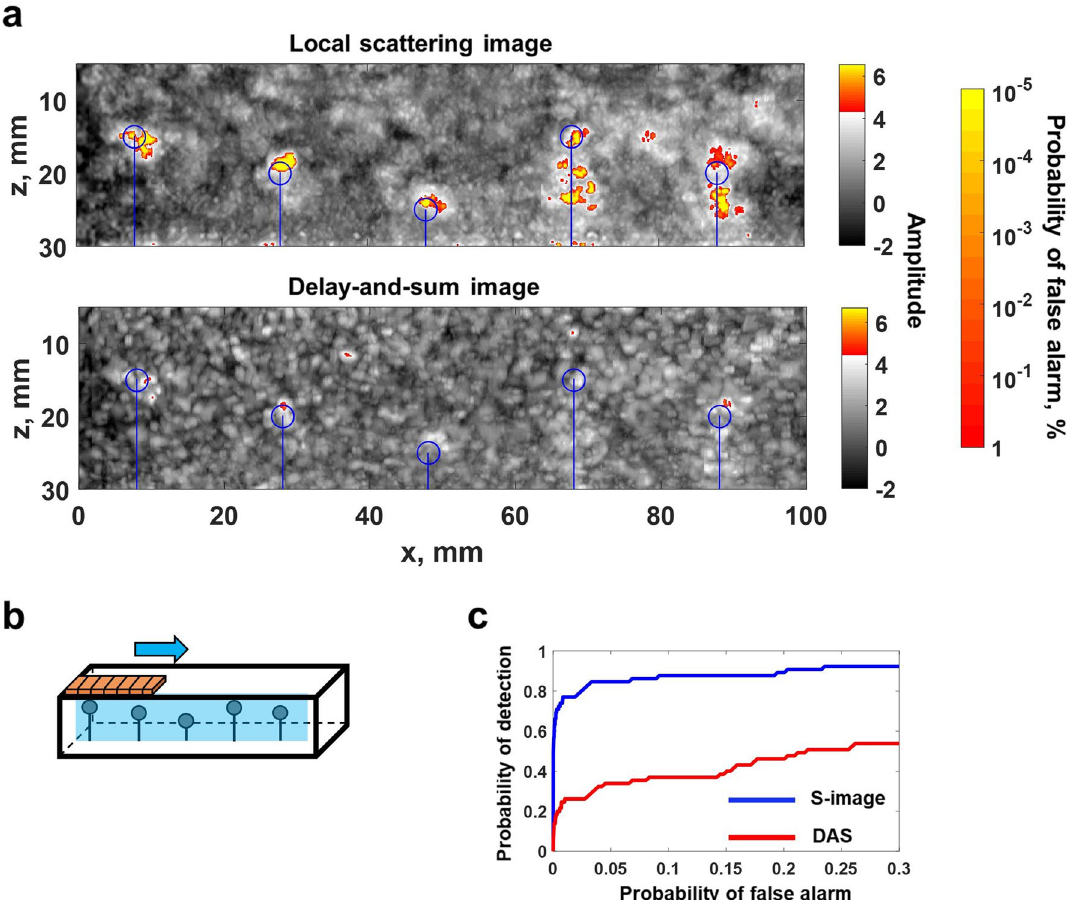
Figure 6. Experimental example of local scattering imaging: scanning along the urethane-rubber sample. ( a ) Local scattering and delay-and-sum images, the value of each pixel equals to the maximum over all scanning array positions. Blue circles indicate the nominal position of inclusions. The global false alarm rate is shown as the second colorbar. ( b ) Diagram illustrating the geometry of the sample. ( c ) Receiver operating characteristic (ROC) curve, summarising the detection statistics over all scanning positions for all